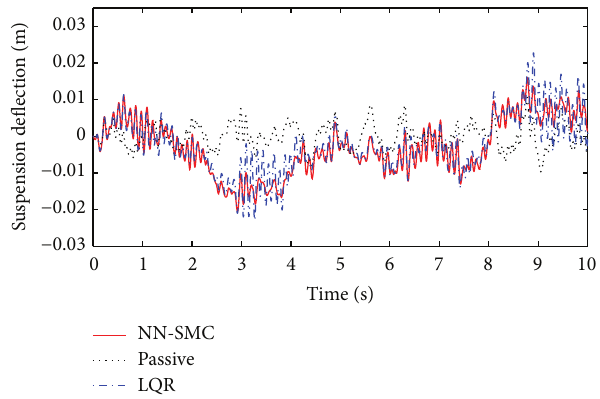
Figure 13: Suspension deflection (Case 3).